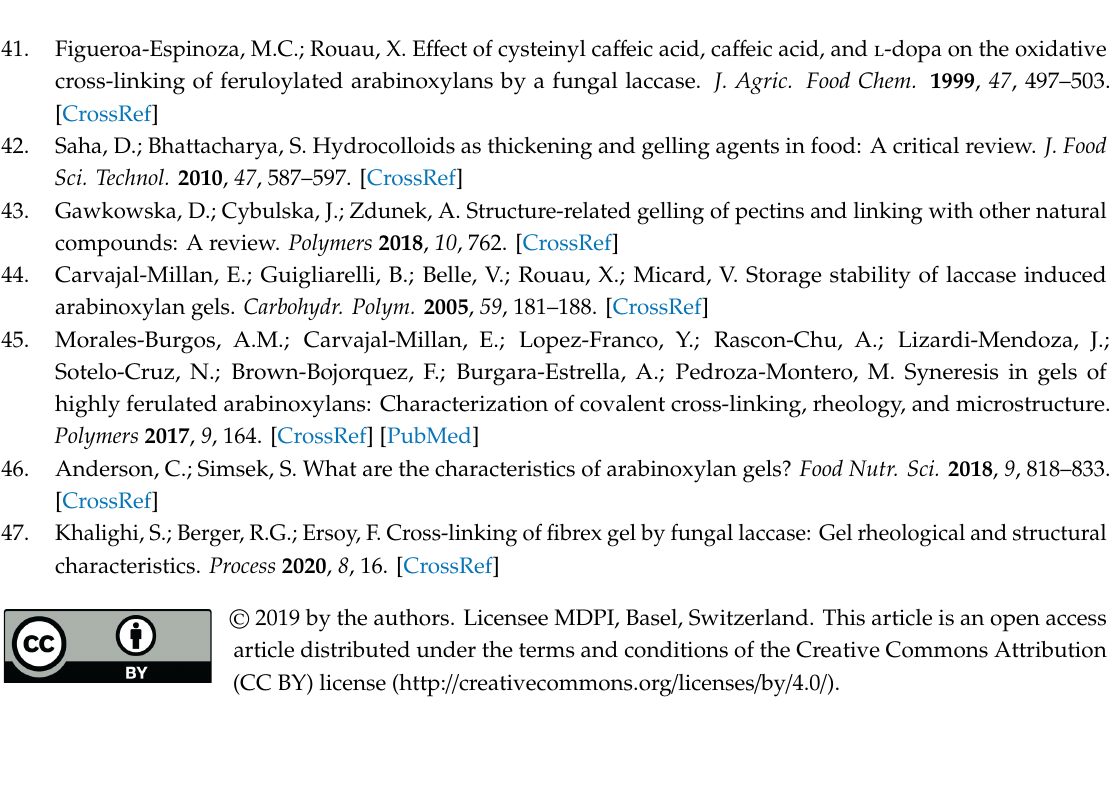
Figueroa-Espinoza, M.C.; Rouau, X. E ff ect of cysteinyl ca ff eic acid, ca ff eic acid, and l -dopa on the